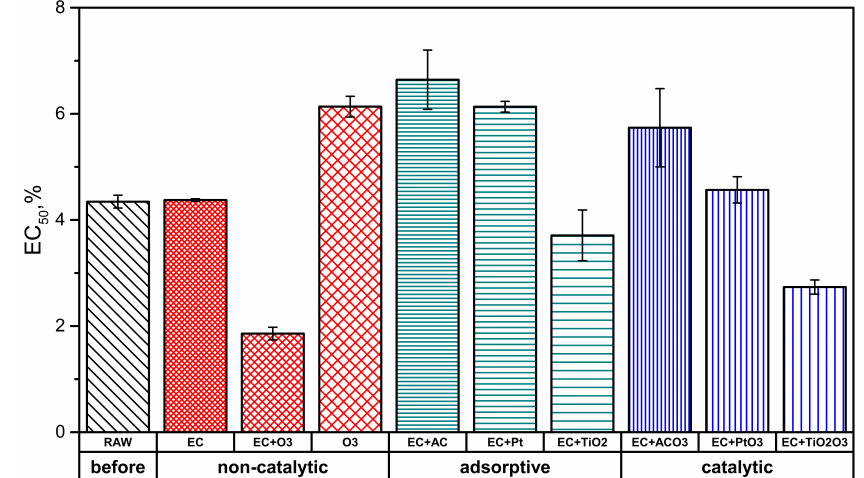
Figure 5. Toxicity assessment. The values of EC 50 after the treatments: non-catalytic, adsorptive, and